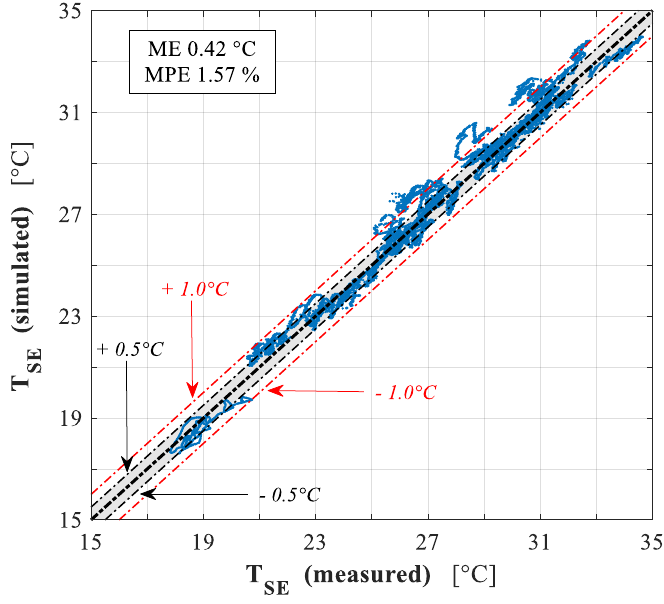
Figure 23. South-East wall temperature: simulated vs. experimental results (from February to November).